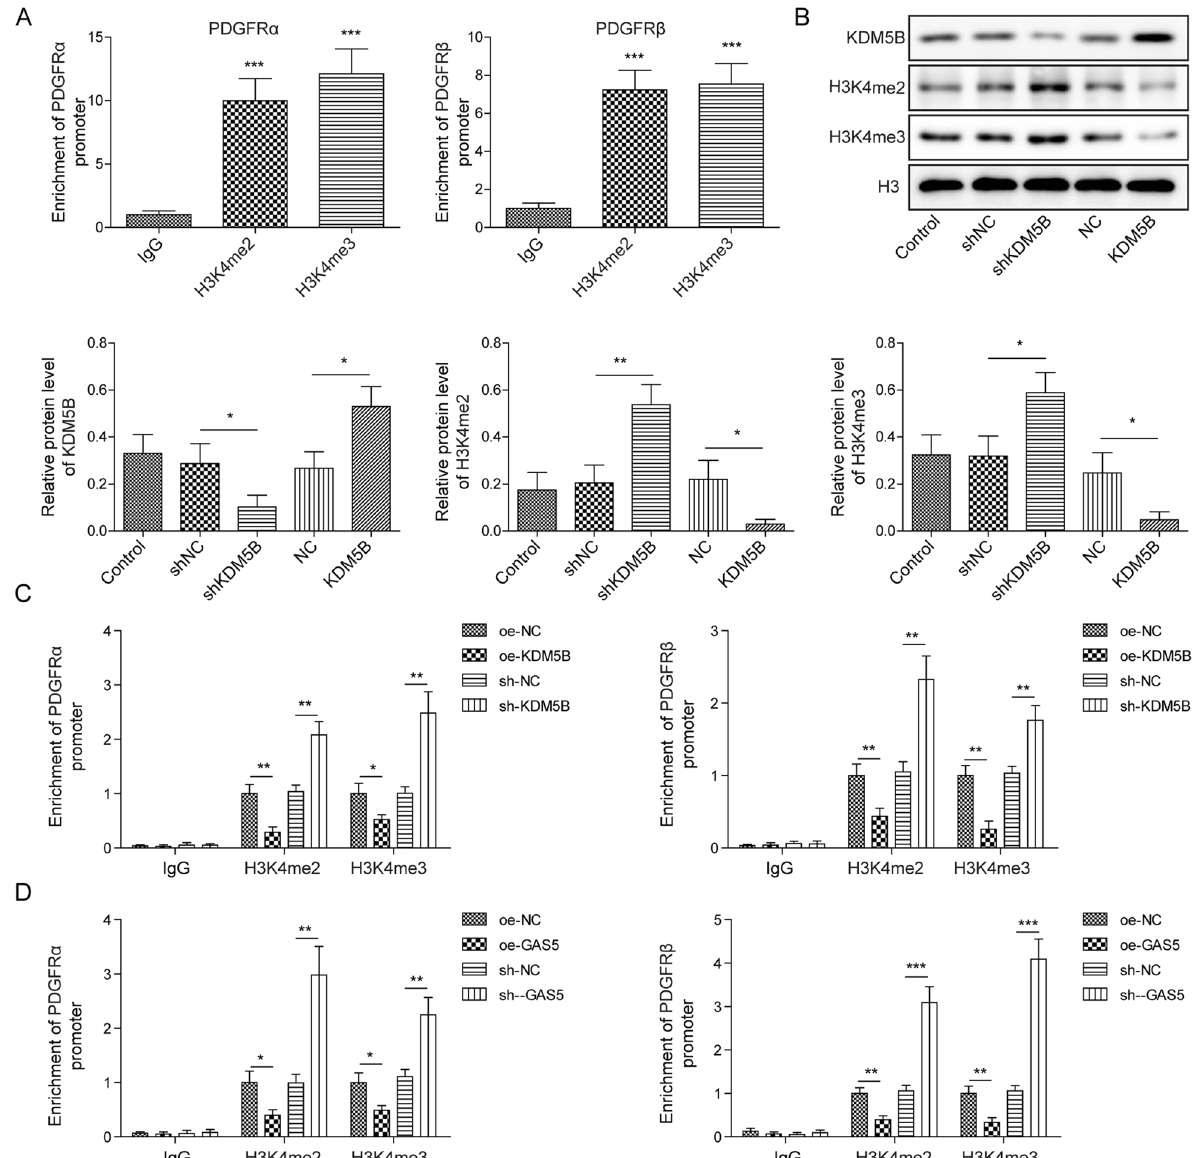
Fig. 6 GAS5 facilitated H3K4me2/3 demethylation to downregulate PDGFRα/β by recruiting KDM5B. A The binding between H3K4me2/3 and the PDGFR α/β promoter was confirmed by ChIP assay. B The protein levels of KDM5B and H3K4me2/3 after KDM5B knockdown or overexpression were detected via Western blotting. C ChIP assay analysis of the binding between H3K4me2/3 and the PDGFR α/β promoter in KDM5B-silenced or KDM5B-overexpressed pericytes. D The interaction between H3K4me2/3 and the PDGFR α/β promoter after GAS5 silencing or overexpression was determined via ChIP assay. For A–D, n 3. * P < 0.05, ** P < 0.01, *** P < =